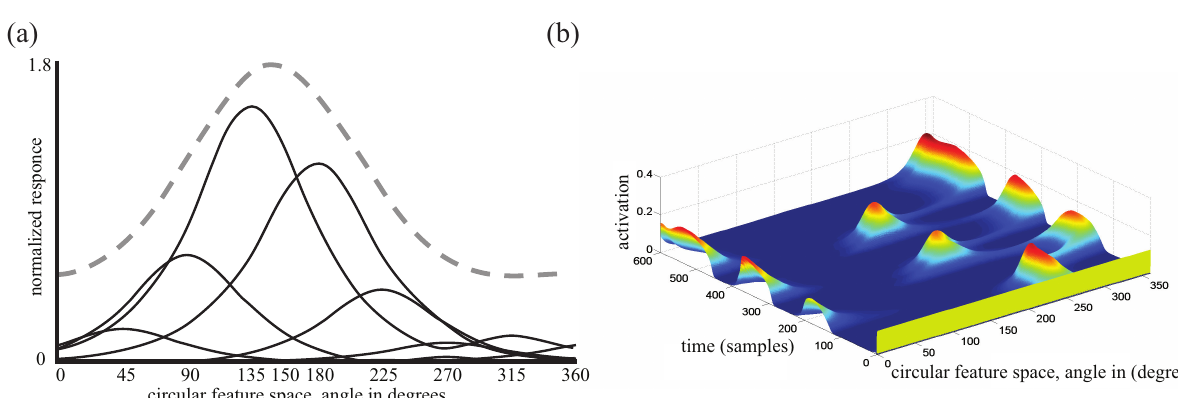
Figure 6. (a) The DPA response for a specific time step given an observed projected relative angle of 150 degrees. (b) The 2D memory trace of the projected relative angle between pelvis and right foot in the x − y -plane for forward walk